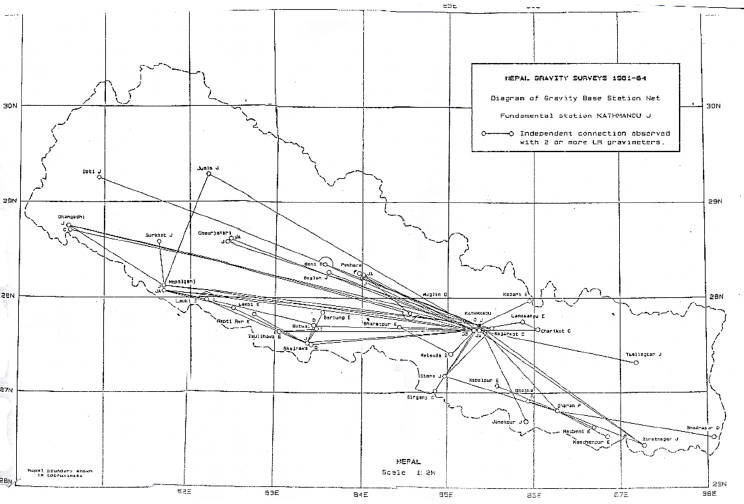
Figure 11. Network of gravity base stations during 1981–1984 [45].